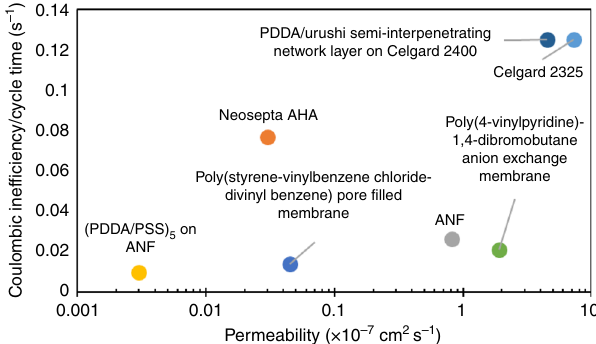
Fig. 4 Comparative evaluation of separator/membrane permeability and coulombic inef fi ciency (CIE)/cycle time degradation rates observed in fl ow cell charge/discharge experiments between aramid nano fi bre (ANF) separators and other nonaqueous redox fl ow battery separators and membranes. Vanadium acetylacetonate was used as the active species in all cases with the exception of ref. [26] with pore- fi lled membrane, which used metal